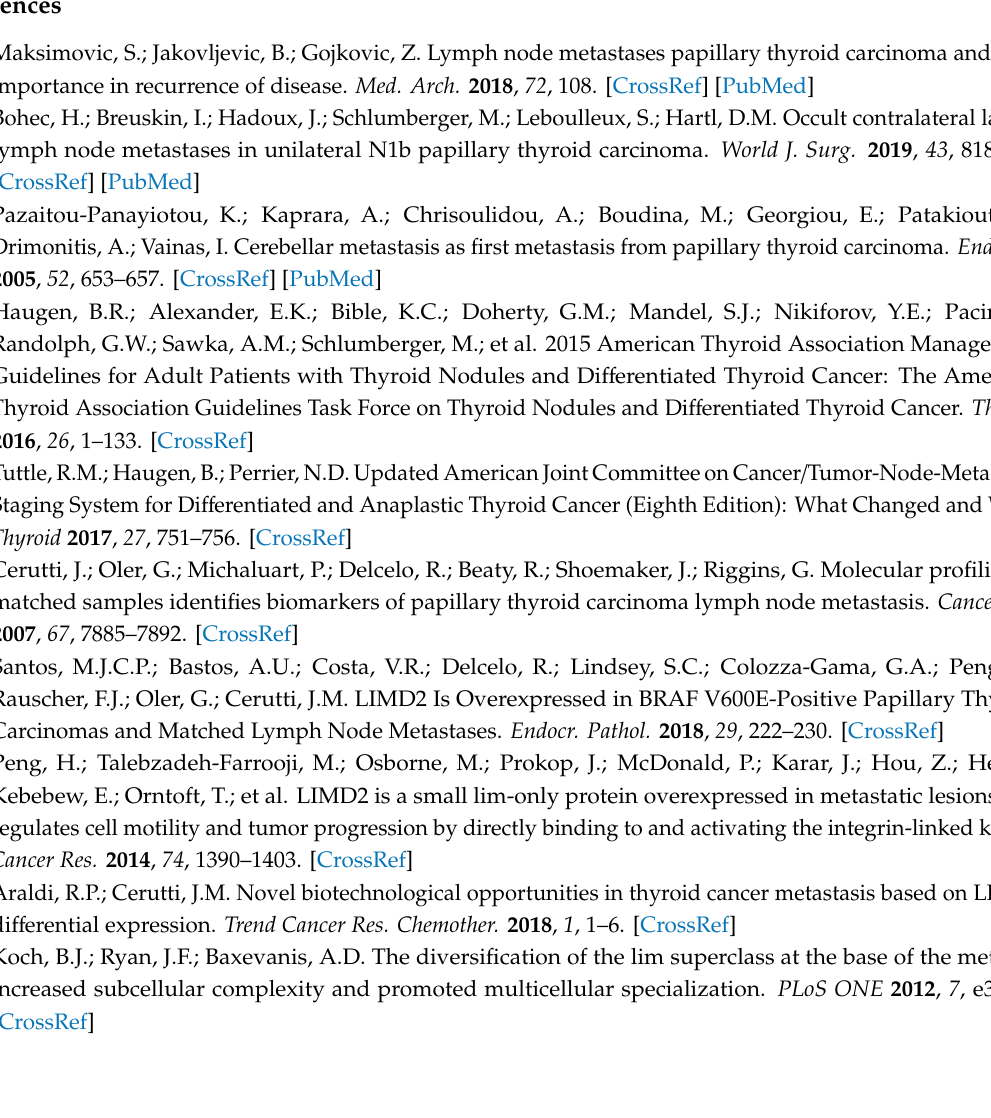
Figure S1: Results of o ff -target analyses, Figure S2: DNA sequencing results of the isolated clones, Table S1: Results of copy number variation (CNV)